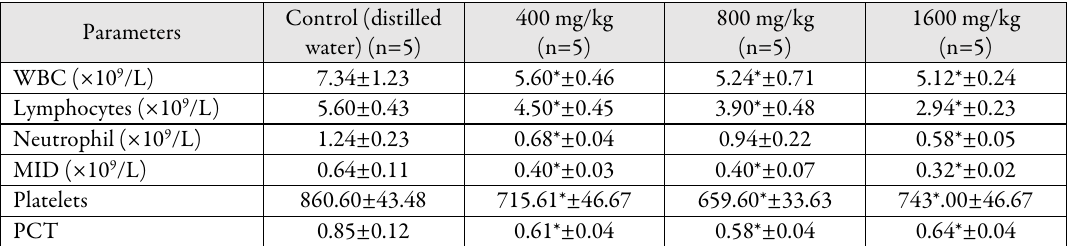
Table 4. Effect of calabash chalk on total white blood cells, white blood differentials and platelets of Wistar